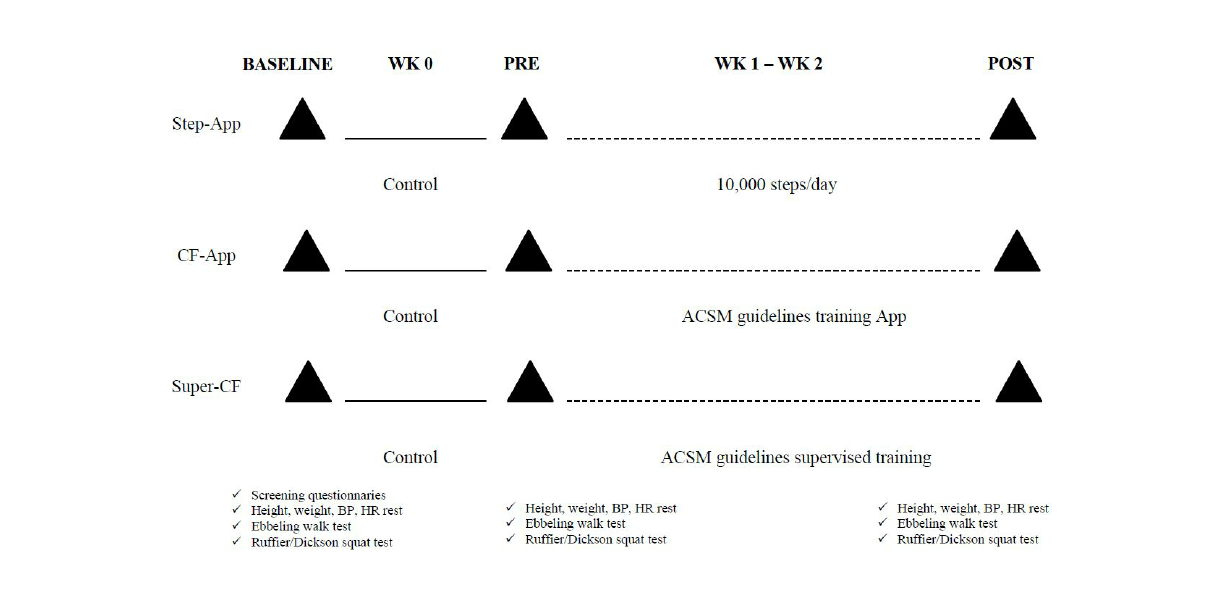
Figure 2. Study protocol